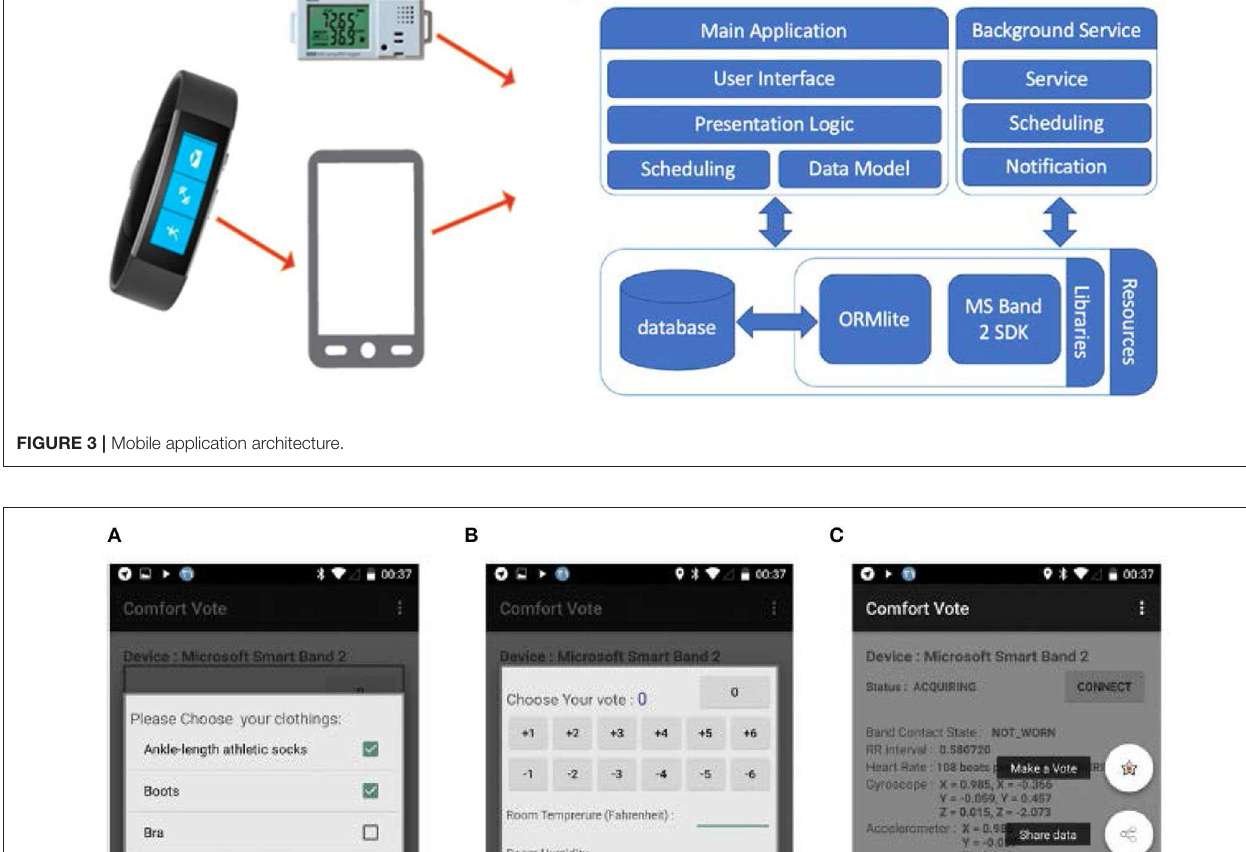
Frontiers in Built Environment |